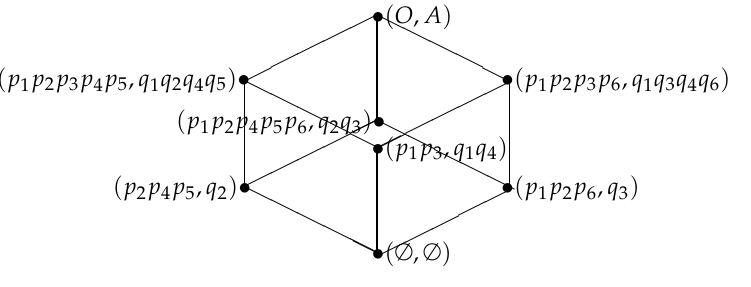
Figure 1: The Hasse diagram of O ( O , A , I ) Figure 1. The Hasse diagram of O ( O , A , I )